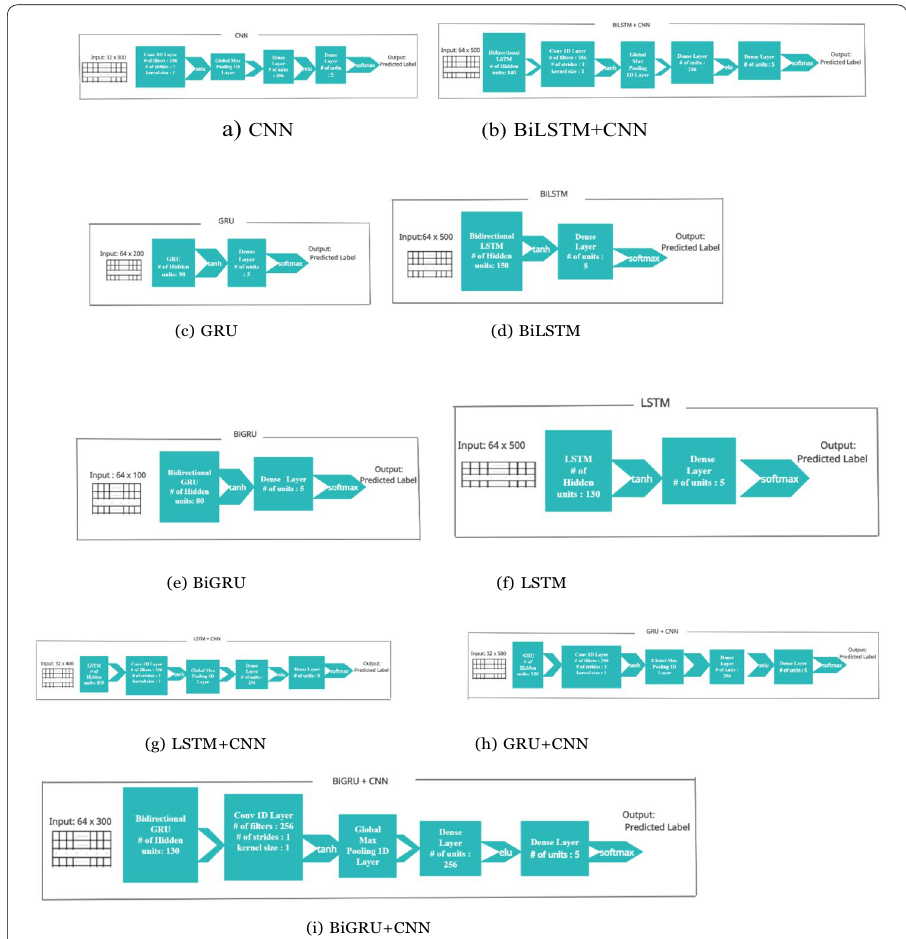
Fig. 3 Layer configuration and parameter settings of various deep learning models used in the proposed